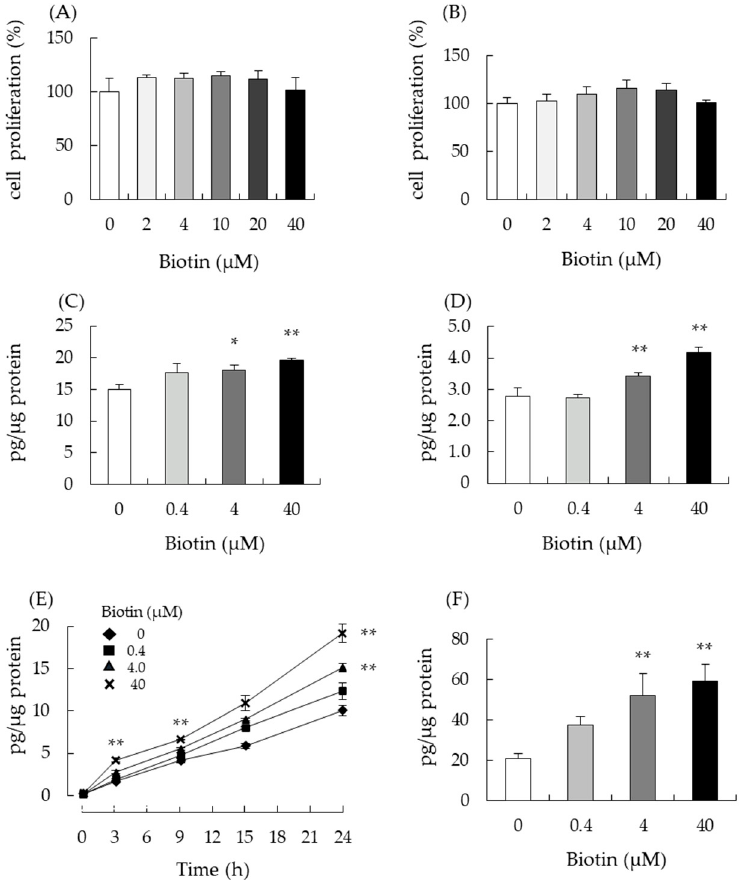
Figure 2. Biotin enhances testosterone production in mouse testis-derived tumor cells. The effect of 24 h of biotin treatment on cell proliferation of I-10 ( A ) and MA-10 cells ( B ) were evaluated by WST-1 assay. Testosterone levels in cultured media, as measured by ELISA after 24 h treatment with biotin, are shown for I-10 cells ( C ) and MA-10 ( D ). The same was done for progesterone levels in the media after 24 h biotin treatment of I-10 cells ( F ). ( E ) Testosterone levels of I-10 cells in a cultured medium after biotin treatment (0, 3, 9, 15, and 24 h) were measured by ELISA. Data are presented as mean ± standard error (n = 3). * p < 0.05, ** p < 0.01 vs. 0 µM biotin group, Tukey–Kramer test.